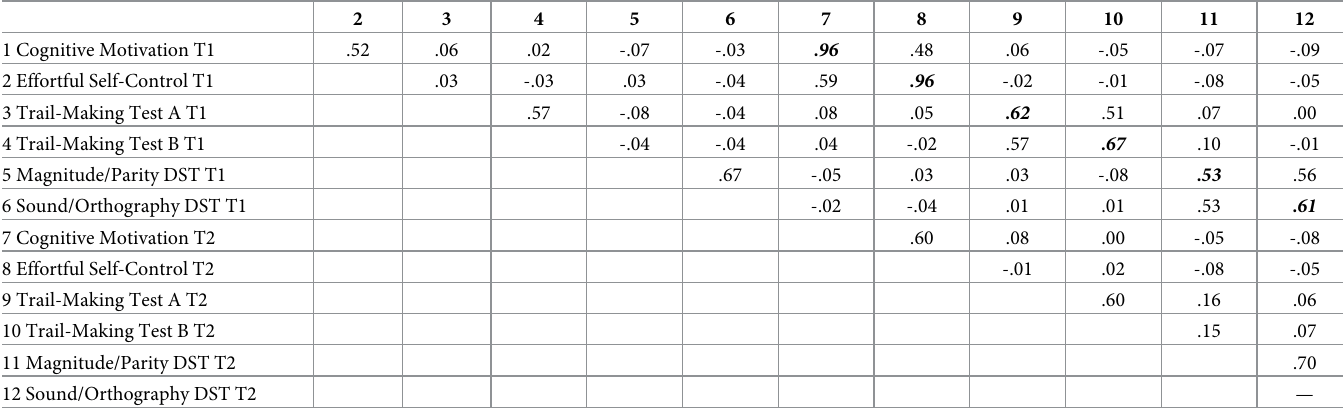
Table 5. Pearson correlations of the normalized variables used for latent state-trait modeling: New demand avoidance